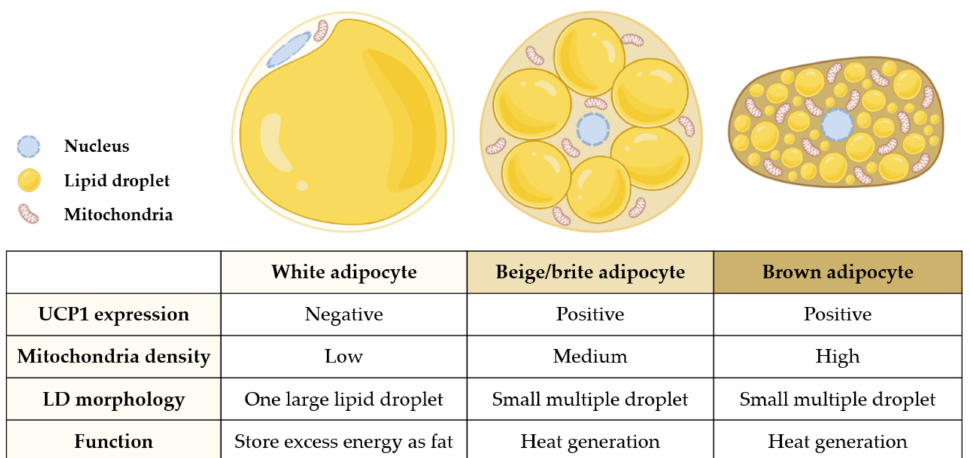
Figure 1. Characteristics of adipocytes. The figure represents distinct characteristics of white, beige, and brown adipocytes. UCP1, uncoupling protein 1; LD, lipid